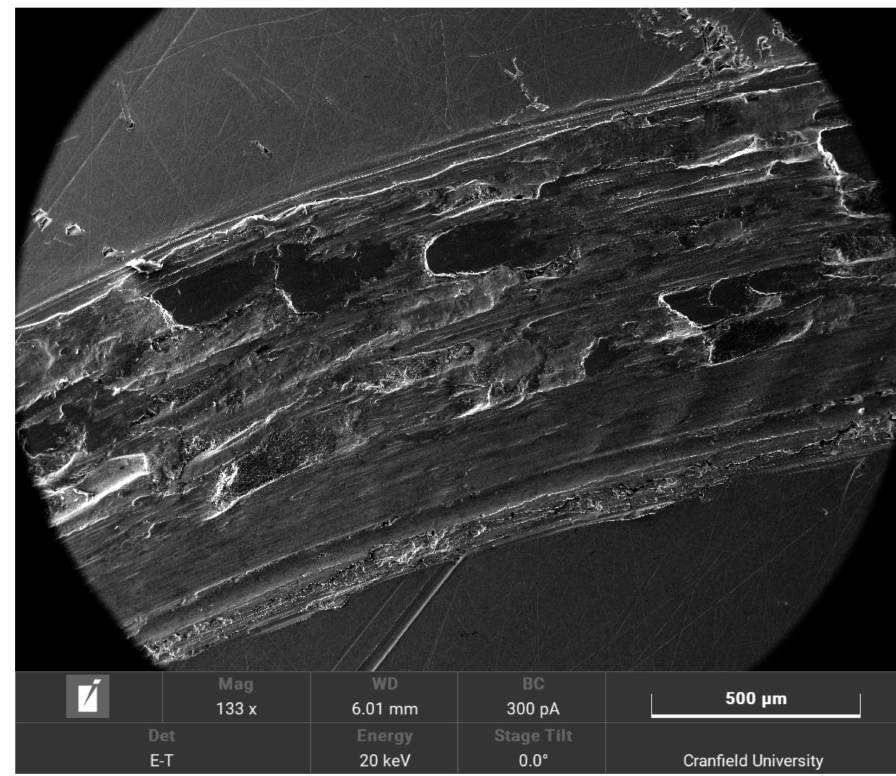
Figure 5. SEM image of the iron sample.